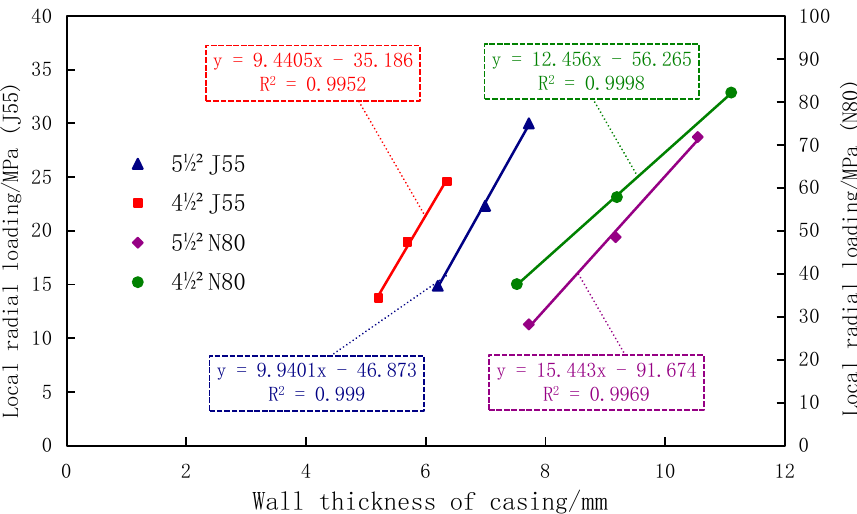
Energies 2019 , 12 , x FOR PEER REVIEW Figure 22. Relation between local radial loading and casing wall thickness. Figure 22. Relation between local radial loading and casing wall thickness.